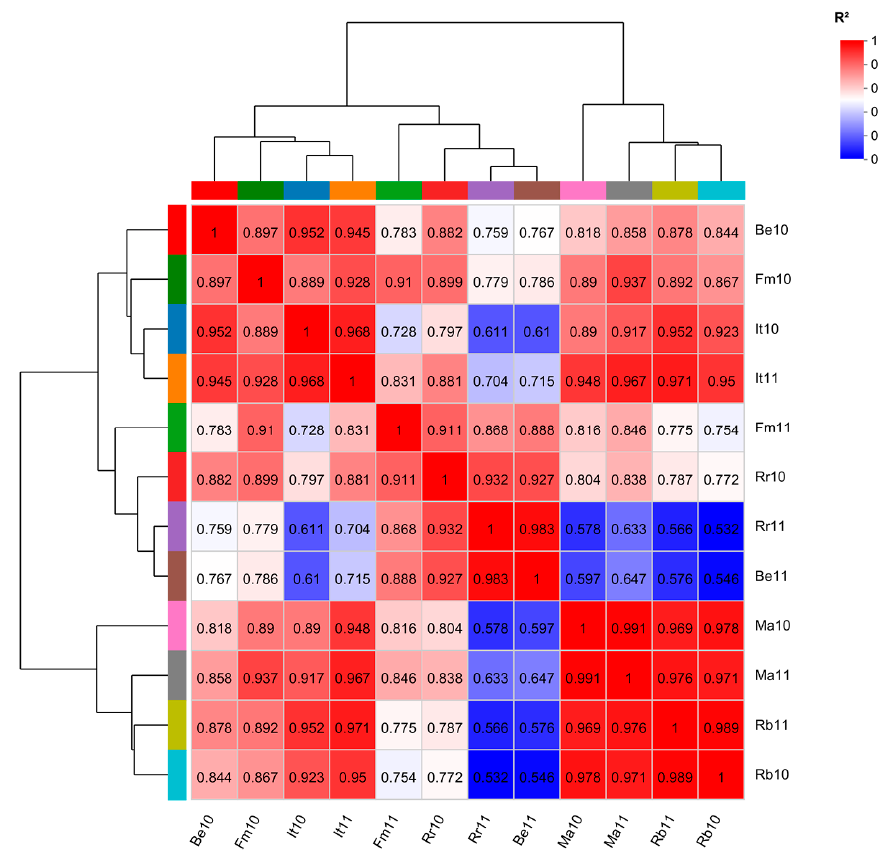
Figure 3. Correlation heatmap of six varieties (three groups).